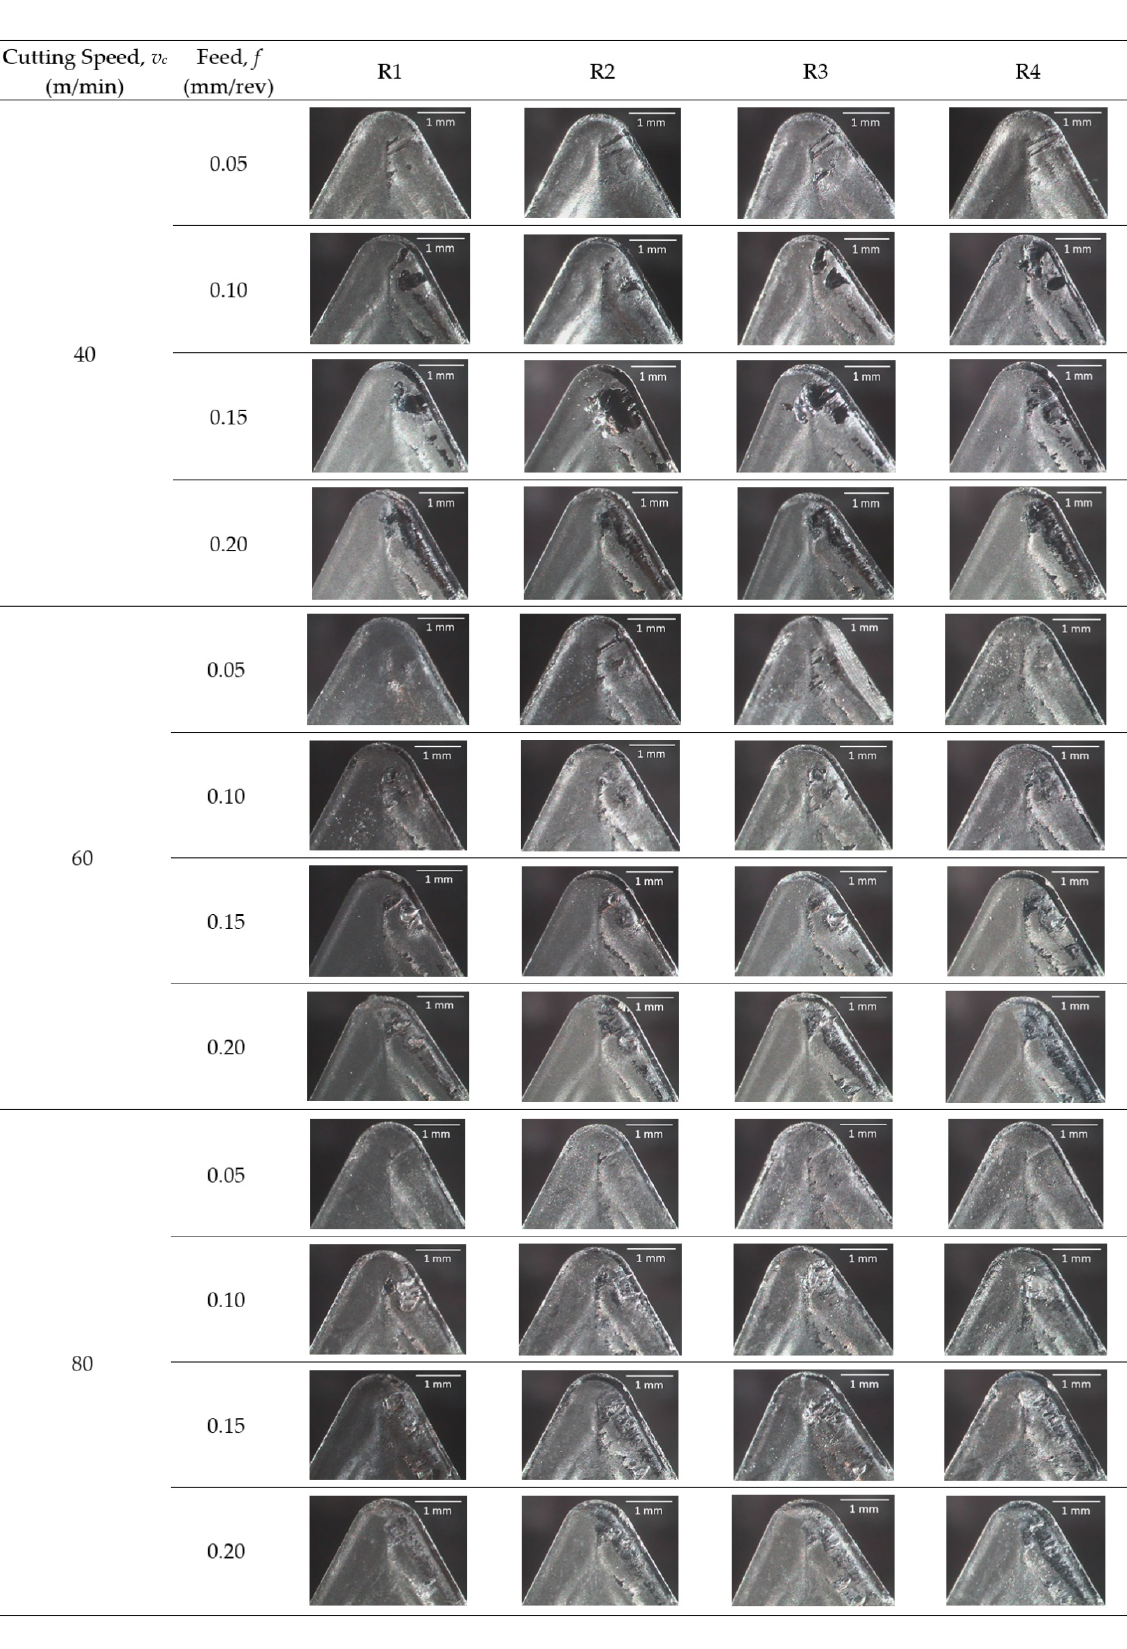
Figure 6. SOM images (30×) of the tool rake face after machining test for each cutting parameters combination.